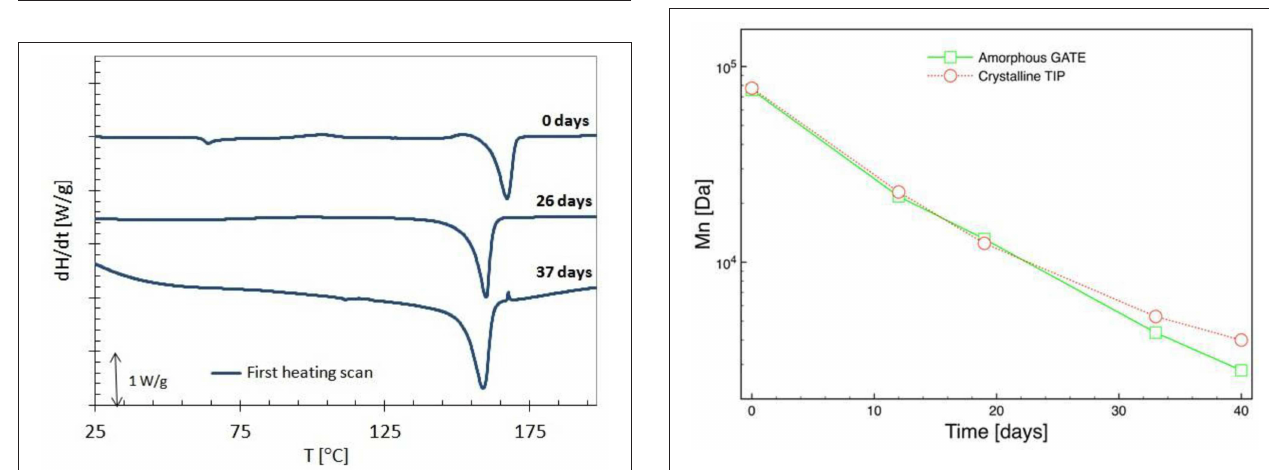
FIGURE 9 | DSC curves of crystalline zone of biphasic samples at different time of degradation.